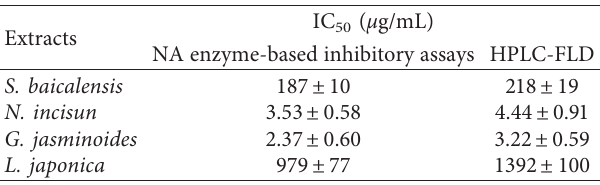
Table 4: The IC 50 values of 4 extracts assayed with NA enzyme- based inhibitory assays and the HPLC-FLD method. Extracts NA enzyme-based inhibitory assays